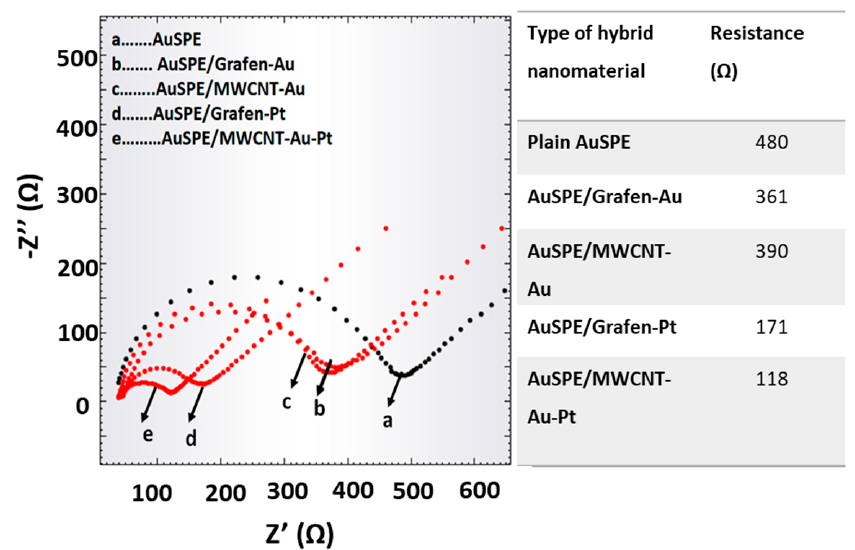
Figure 1. Nyquist plots and resistance values of plain AuSPE, AuSPE/graphene-Au, AuSPE/MWCNT-Au, AuSPE/graphene-Pt, and AuSPE/MWCNT-Au-Pt.